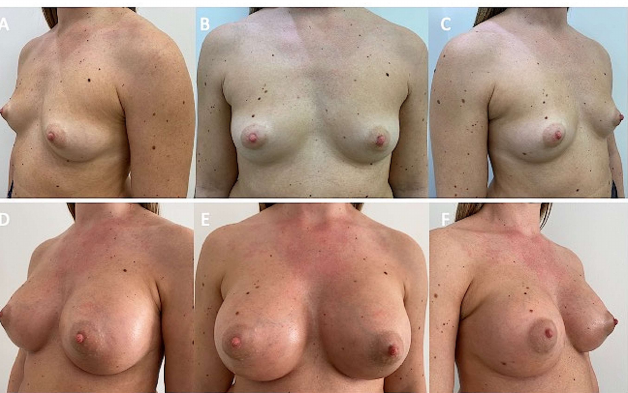
Figure 1. A 30 year-old-female, affected by a moderate grade of bilateral breast hypoplasia, was treated with definitive implants. ( A ) Pre-operative projection in 3 / 4 left view. ( B ) Pre-operative projection in frontal view. ( C ) Pre-operative projection in 3 / 4 right view. ( D ) Post-operative projection after 1 year (T6) in 3 / 4 left view. Definitive implants of 320 cc, round and smooth, were applied bilaterally under the glands—not sub-muscular/dual-plane. ( E ) Post-operative projection after 1 year in frontal view, evidencing the significant breast improvement after one surgical procedure. ( F ) Post-operative projection after 1 year in 3 / 4 right